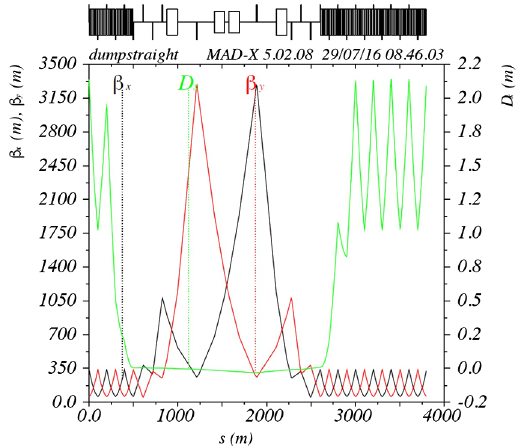
FIG. 8. Layout and optics of the alternative dump concept. The dipoles in the middle represent the septa, the elements to the outside of the straight the extraction kickers.